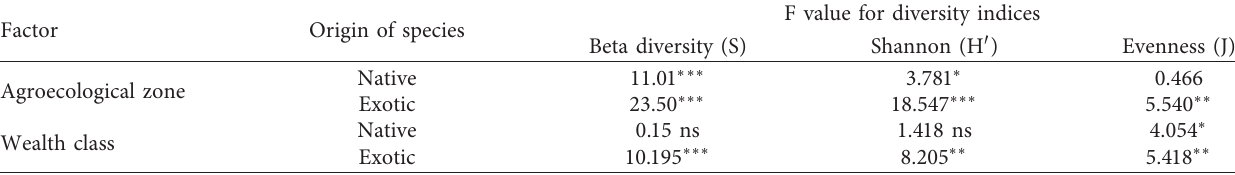
Table 3: Diversity indices F value native and exotic species as influenced by agroecological zone and wealth class. Factor